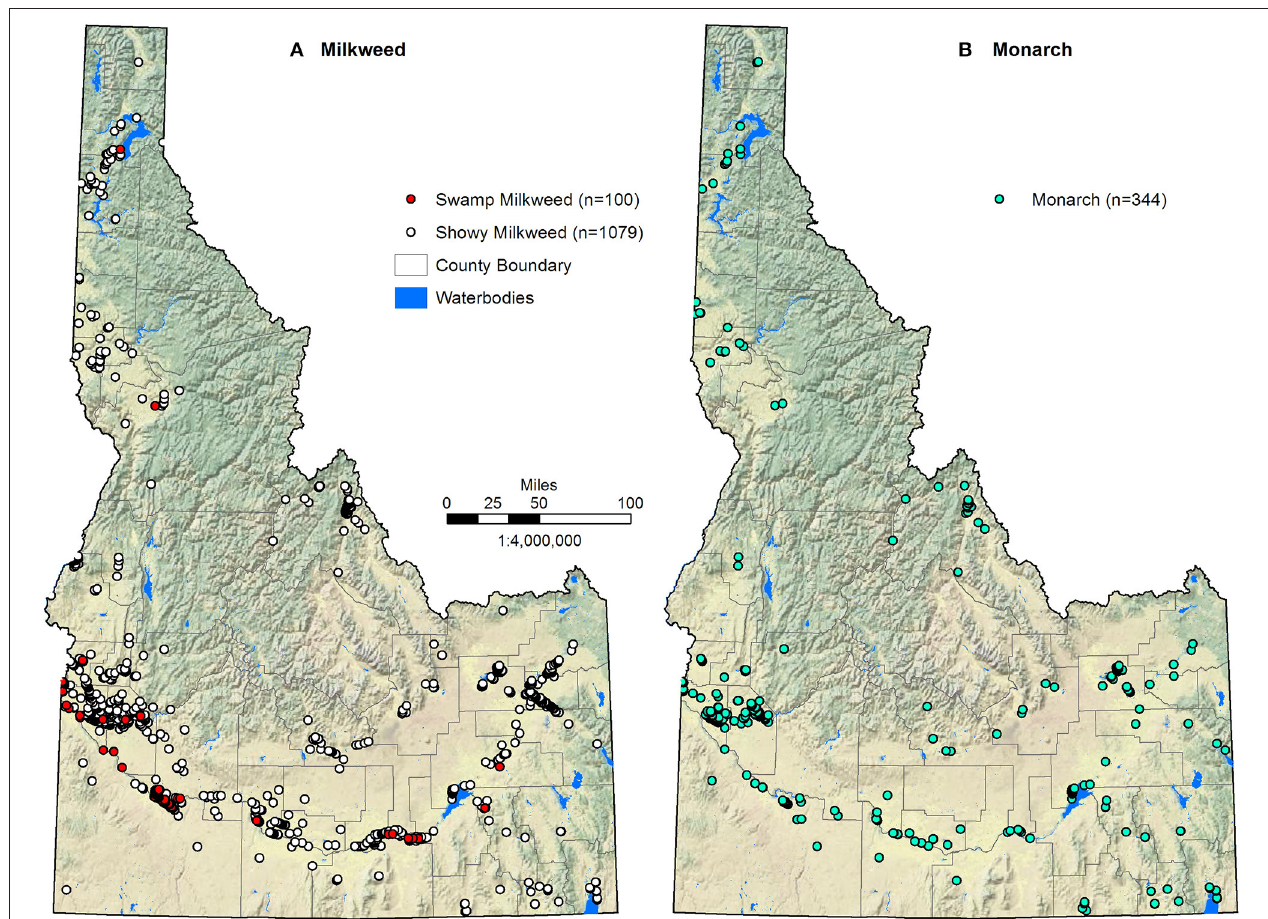
FIGURE 1 | Milkweed (A) and monarch (B) observations used in modeling distributions across